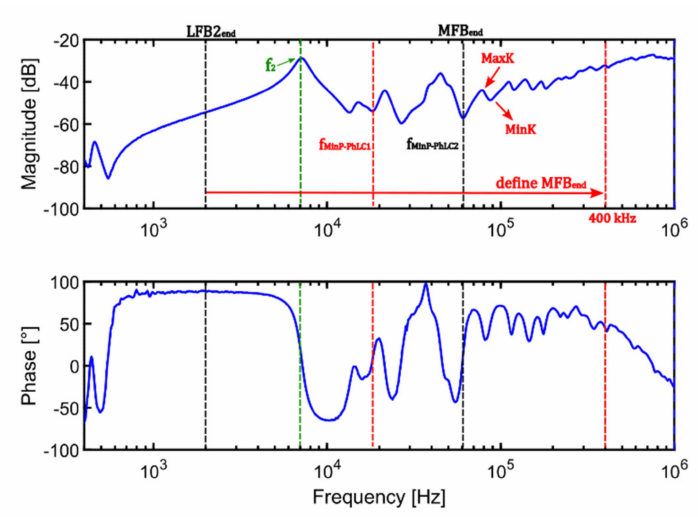
Figure 11. An example of class 1 FRA plot for identification of the MFB end . The algorithm adapts to class 2 if no minimum peak is found in the range MFB start to 400 kHz for which phase changes from inductive to capacitive (MinP-PhLC1). In this class, a maximum peak is searched between 30 kHz and 400 kHz, which fulfills the condition of phase zero-crossing from inductive to capacitive, as shown in Figure 12. If such a peak is found, MFB end becomes the frequency of this point, MFB end = fMaxP-PhLC; otherwise, a new maximum peak is searched between 30 kHz and 400 kHz, and process